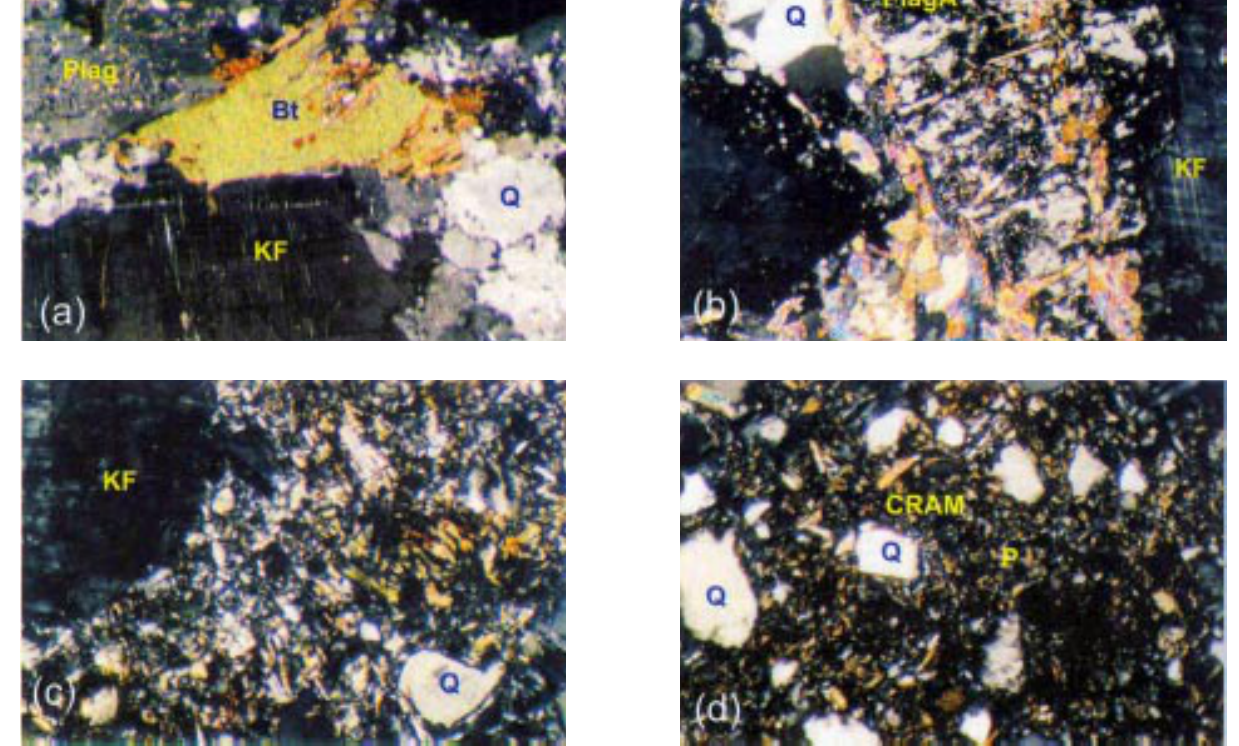
Figura 1. Microfotografias ao longo do perfil 1 - Argissolo Vermelho-Amarelo. (a) Fácies rocha fresca (KF = feldspato potássico, Plag = plagioclásio, Bt = biotita e Q = quartzo); (b) Fácies alterito - horizonte (PlagA = plagioclásio argilizado); (c) Fácies de transição-horizonte BC, evolução dos processos C 3 de argilização; (d) Fácies sólum-horizonte Bt (Q = quartzo - esqueleto, P = plasma, CRAM = cristais relictuais à alteração mineralógica). (Obj 6.3x; Oc